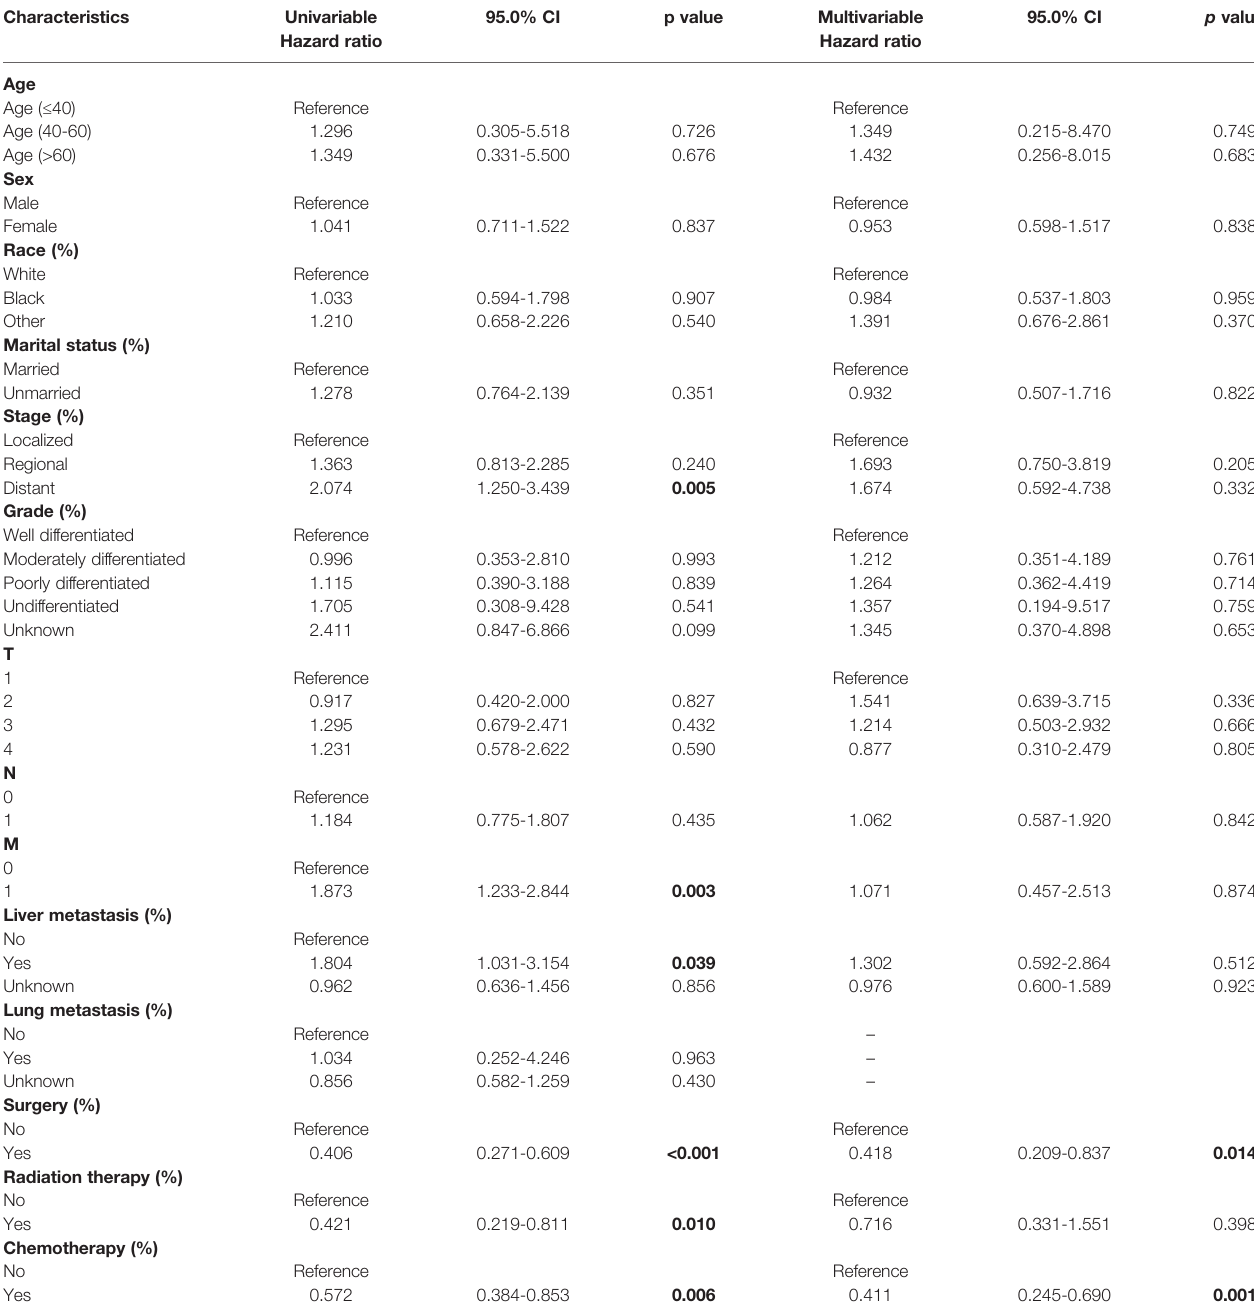
TABLE 2 | Univariate and multivariate analyses of patients with